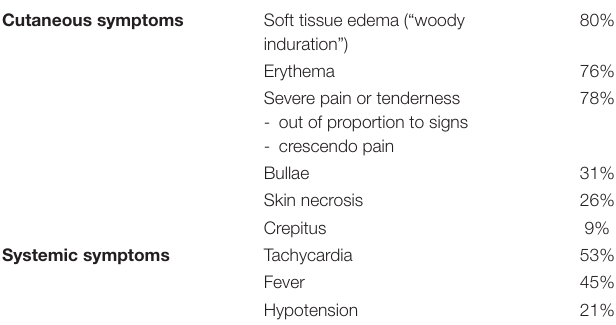
TABLE 2 | Summary of occurrence of cutaneous or systemic symptoms of necrotizing soft tissue infections (14–37). Cutaneous